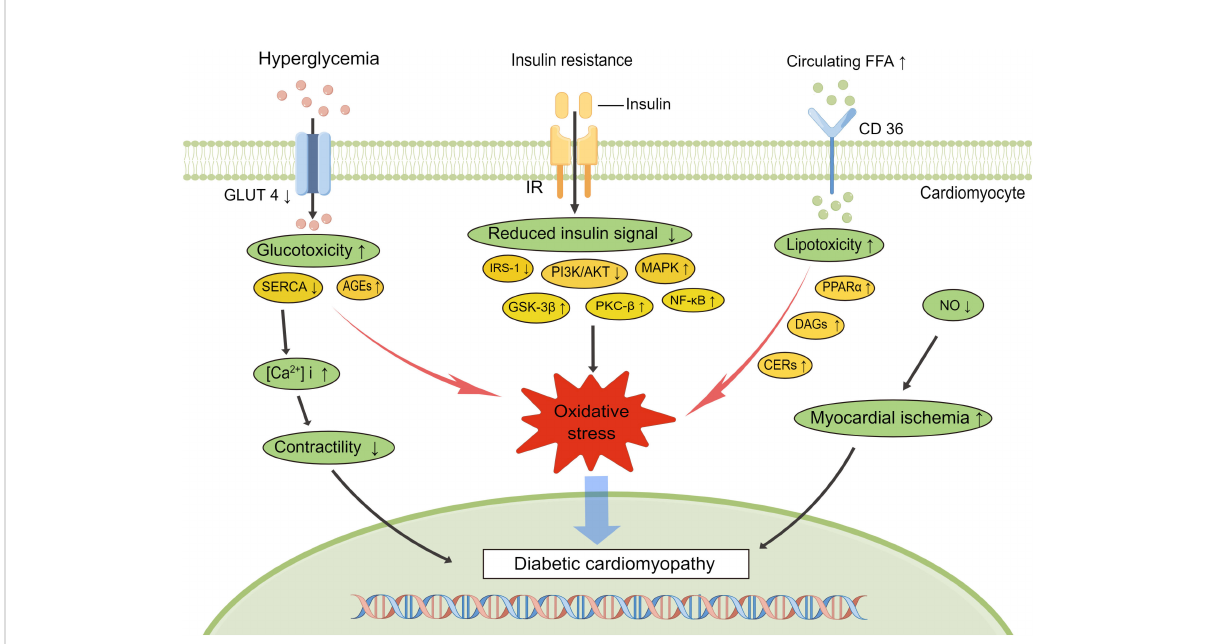
FIGURE 2 Signaling pathways involved in the development of diabetic cardiomyopathy. Diabetes is characterized by hyperglycemia, insulin resistance, and increased circulating free fatty acids, which lead to impaired diabetes signaling, increased in fl ammation, altered Ca 2+ handling, and myocardial ischemia, exacerbating the progress of diabetic cardiomyopathy. AGEs, advanced end glycation products; SERCA, sarcoplasmic reticulum Ca 2+ -ATPase; NO, nitrogen oxide; IRS-1, insulin receptor substrate-1; PI3K, phosphoinositide 3-kinase; MAPK, mitogen-activated protein kinase; GSK-3 b , glycogen synthase kinase-3 b ; PKC, protein kinase C; NF- k B, nuclear factor k B; PPAR a , peroxisome proliferator-activated receptor alpha; DAGs, diacylglycerols; CERs,